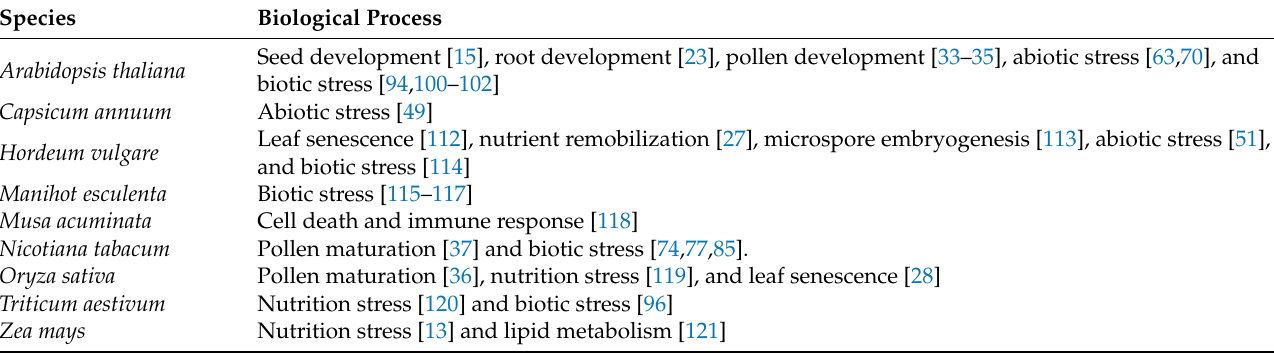
Table 1. Plants with identified ATG genes and potential processes that require